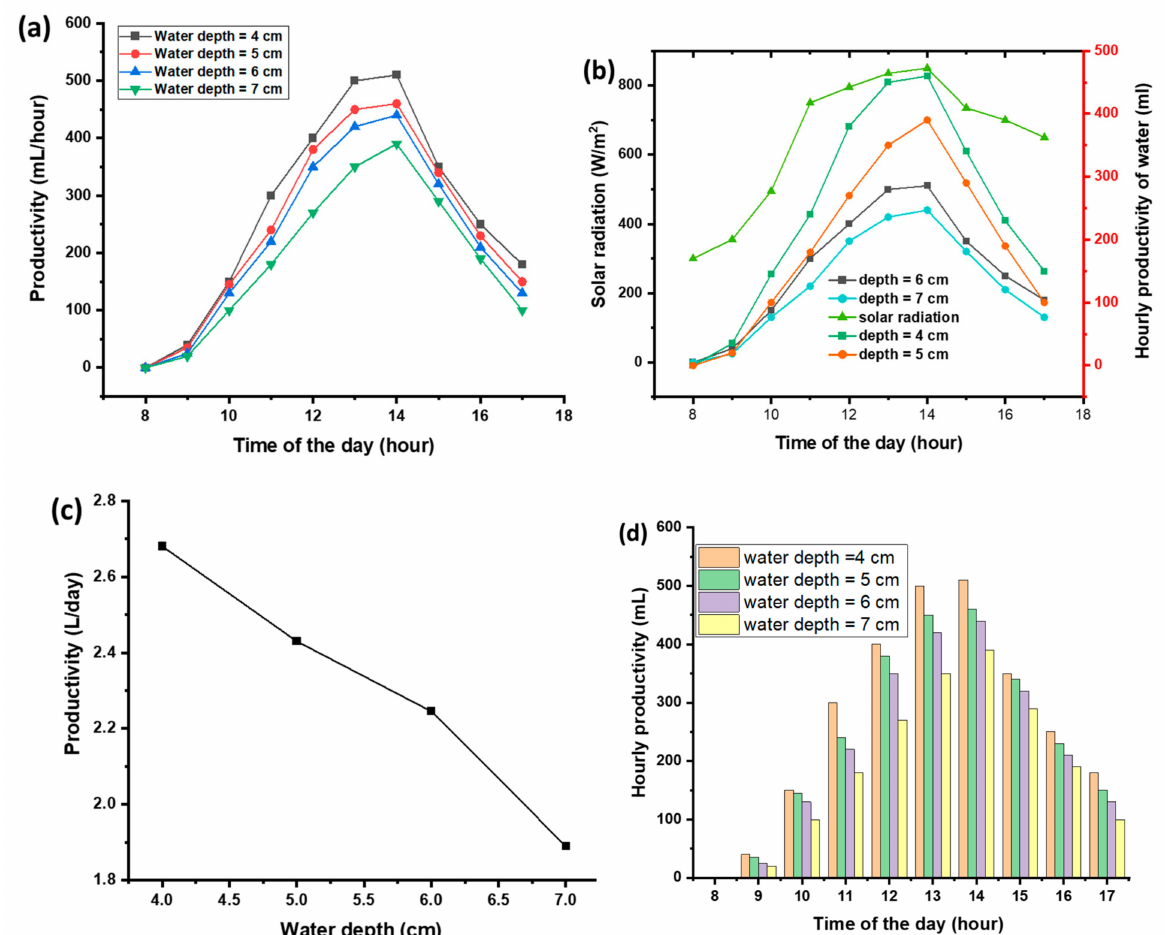
Figure 5. Productivity varies with water depth and time. Productivity with daytime ( a ), solar radiation with daytime ( b ), productivity per day with water depth ( c ), Bar diagram of hourly productivity at different water depths ( d